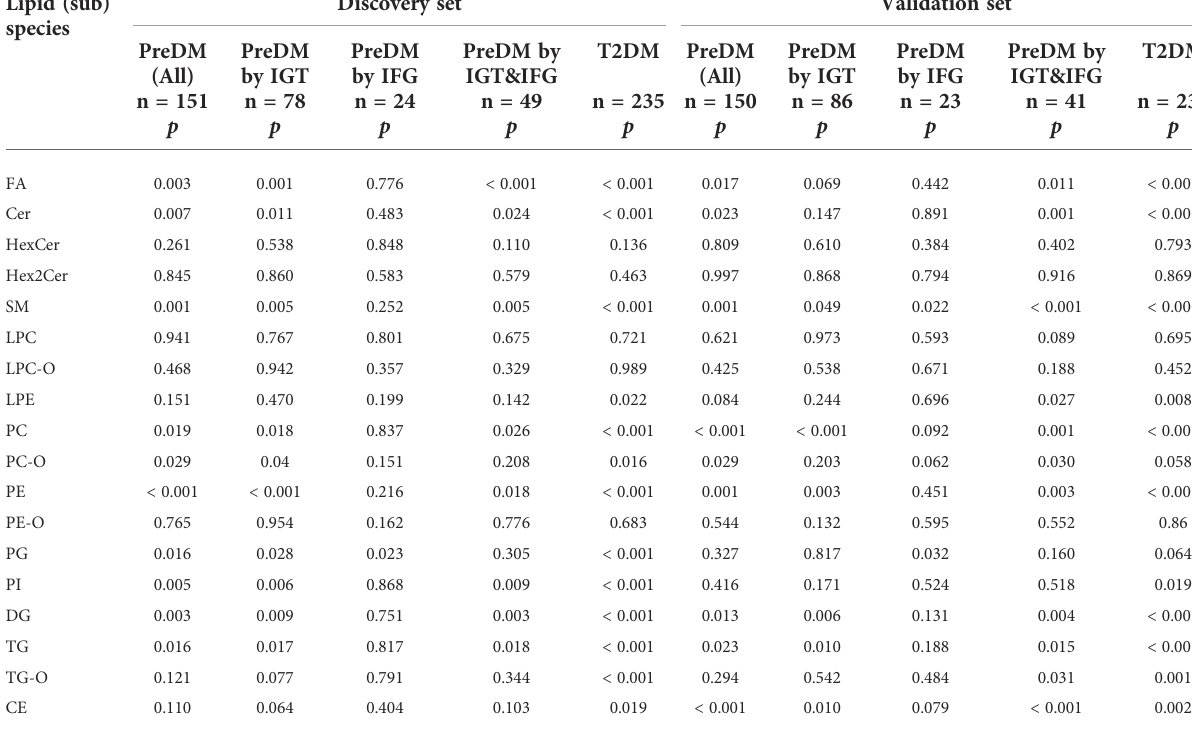
TABLE 2 Statistical differences in lipid (sub)species levels by Mann-Whitney test. Lipid (sub)